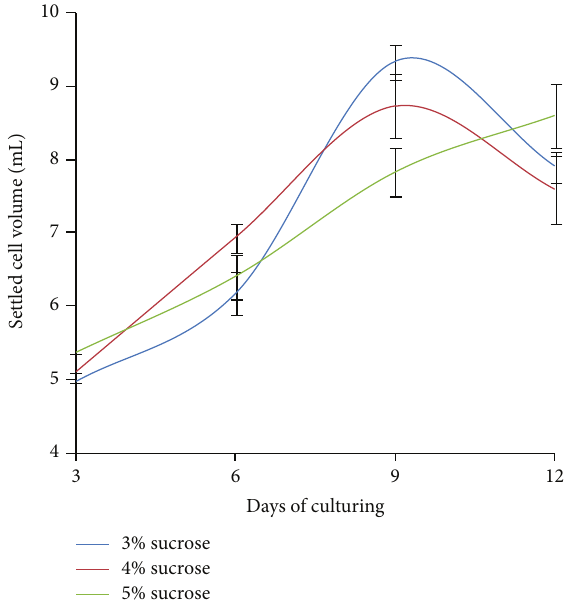
Figure 3: Effects of different sucrose concentrations of sucrose on the establishment of the Mitragyna speciosa cell suspension culture as measured by the settled cell volume (mL) in 25mL of cell culture. The bars indicate the standard